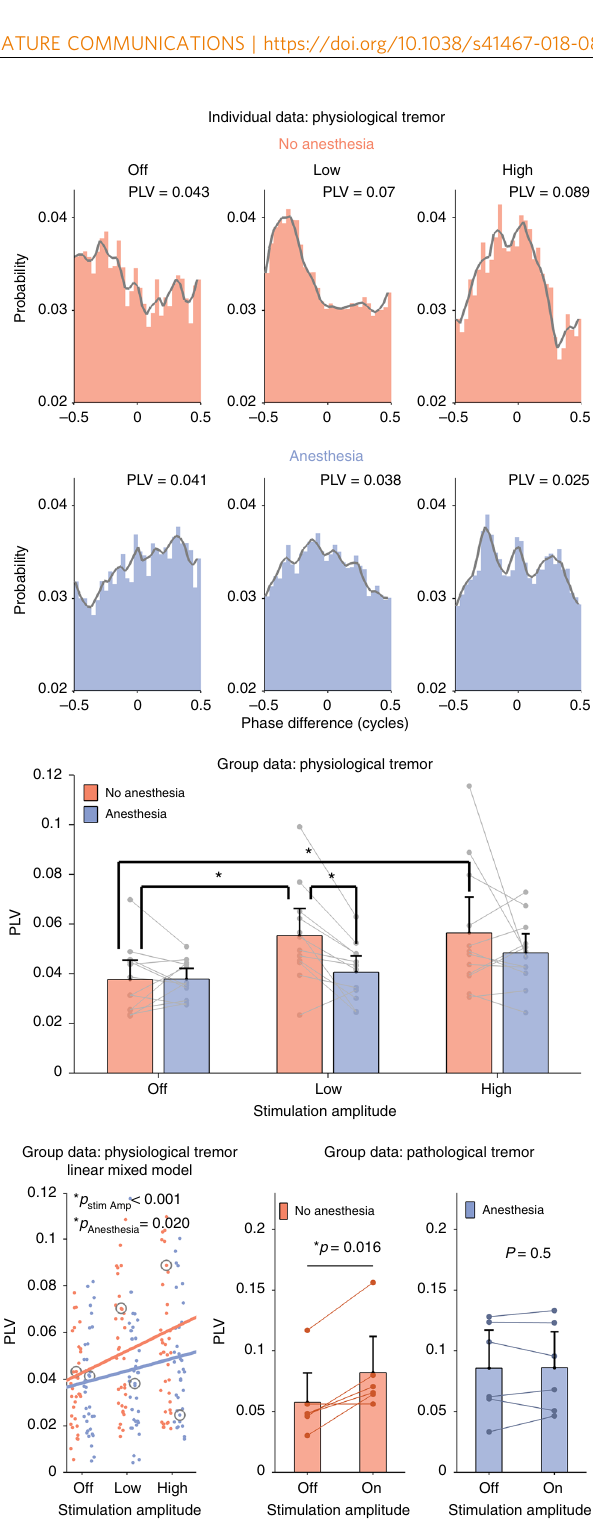
signi fi cant increase in spike rate.